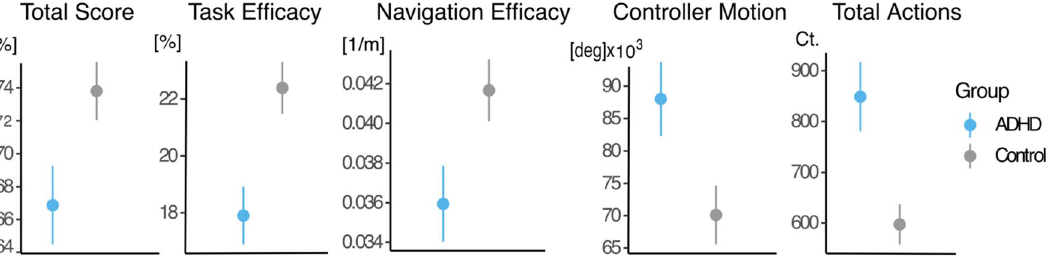
Figure 1. The plot shows mean of the EPELI performance measures in the ADHD and control group. Error bars indicate the standard error of mean.